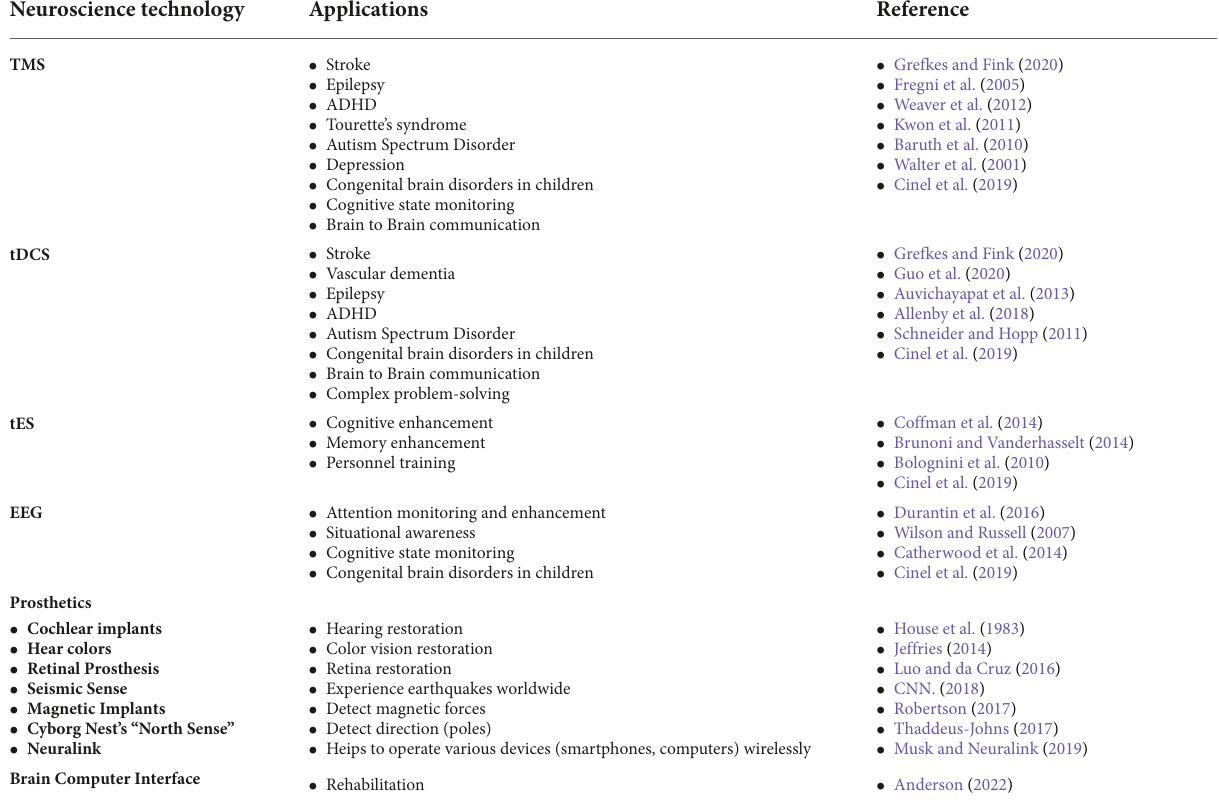
TABLE 2 Current applications of neuroscience technologies in various fields. Neuroscience